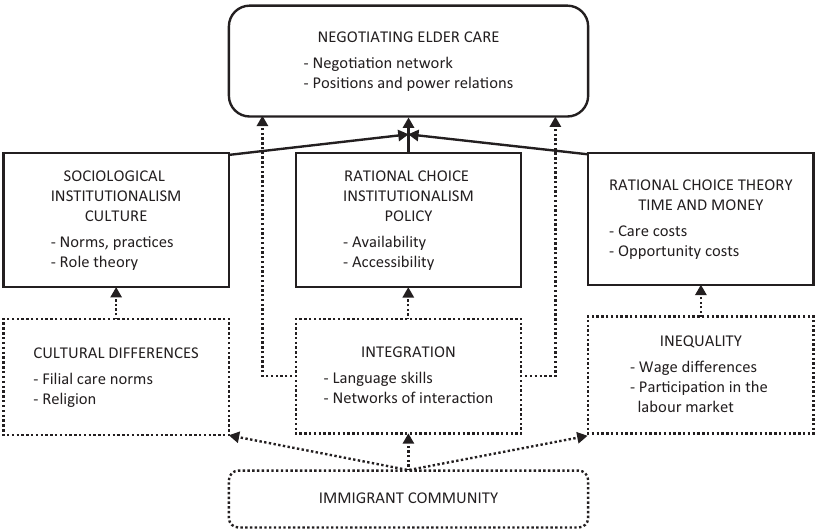
Note: the solid lines refer to the integration of existing elder care theories; the dotted lines indicate how they are related to realities in immigrant communities.